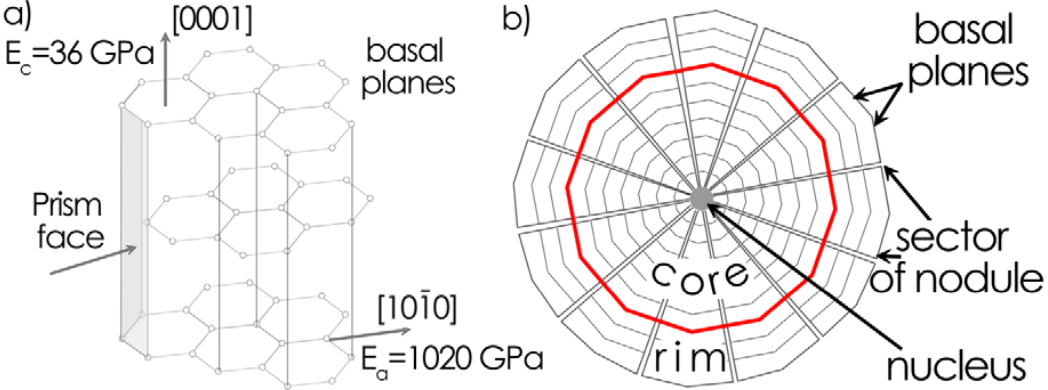
Figure 1. A structure of graphite nodule: ( a ) Elementary cell of the graphite crystal lattice [23], ( b ) a sectorial arrangement of the crystallographic planes in the graphite nodule [25].